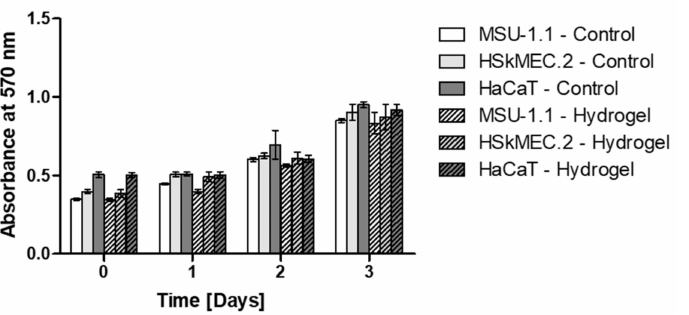
Figure 2. In vitro assessment on biocompatibility of the hydrogel measured by MTT assay. Metabolic activity of MSU-1.1, HSkMEC.2 and HaCaT cells cultured in the presence of hydrogel was measured on day 0, 1, 2 and 3. Untreated cells were used as controls. Data represent mean ± SEM, n = 3; no significant differences were observed between hydrogel-treated cells and untreated